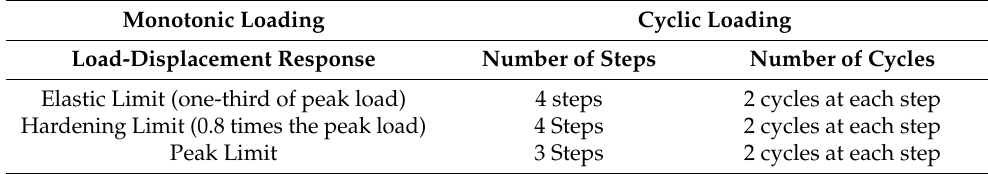
Table 2. Cyclic loading protocol derived from monotonic loading (Adapted from [16,17,64]).